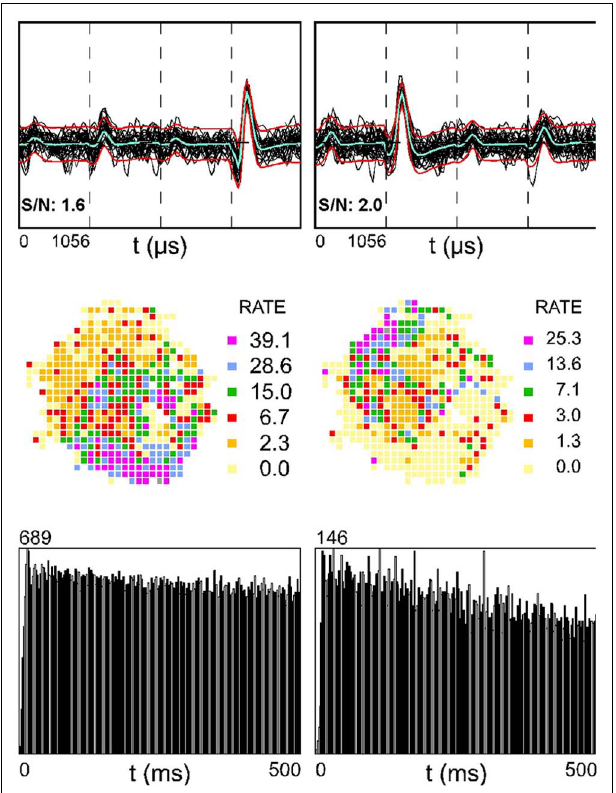
FIGURE 3 |Two simultaneously recorded SDWs in the medial white matter in the absence of somatic activity compared across each wire of a tetrode (top row) and its corresponding firing rate map (second row) and autocorrelogram (third row). The overlay of 60 spikes as well as the average waveform for each SDW is displayed for each wire (top row). The firing rate maps for the SDWs display a complimentary spatial firing pattern where the SDW on the left fires more when the SDW on the right fires at a low rate (second row).The autocorrelograms for each SDW (third row) suggest that they are not theta